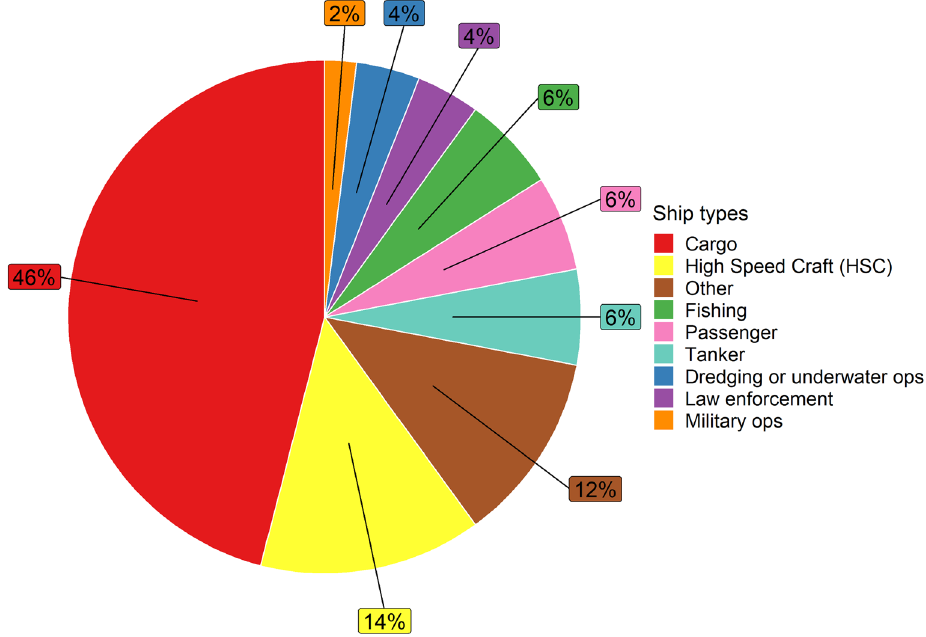
Figure 6. Pie chart of ship types based on those vessel passes where the likely source vessels could be identified from the AIS data (n =